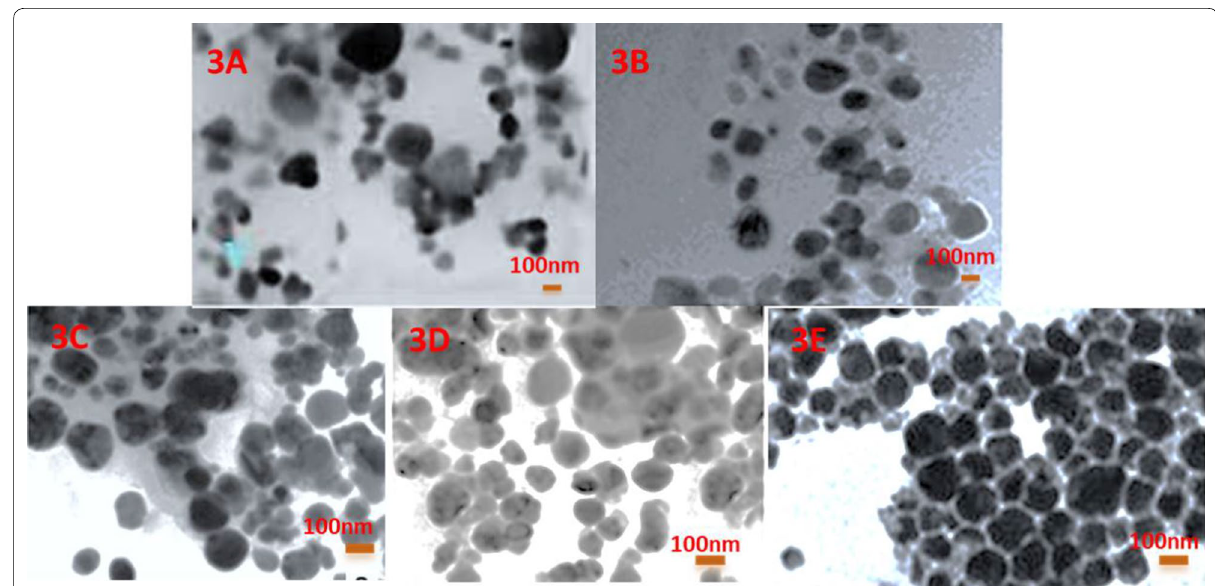
Table 1 Size distribution, zeta potential and PDI of CuO NPs, FOL-PLGA-CuO NPs and CD-1, CD-2 and CD-3 Sl.